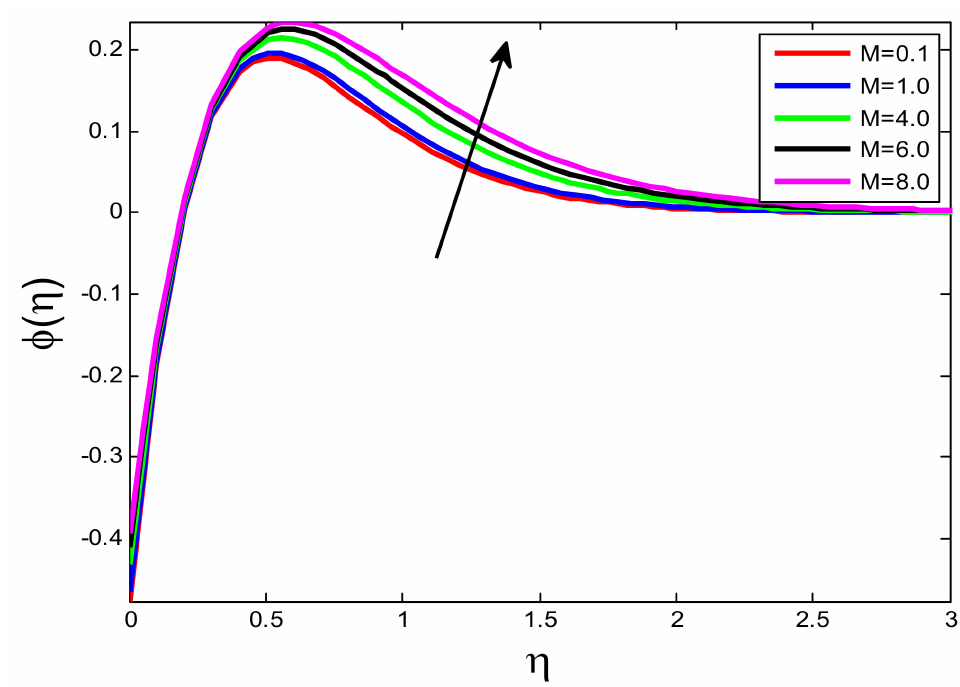
Figure 23. Influence of M on φ ( η )